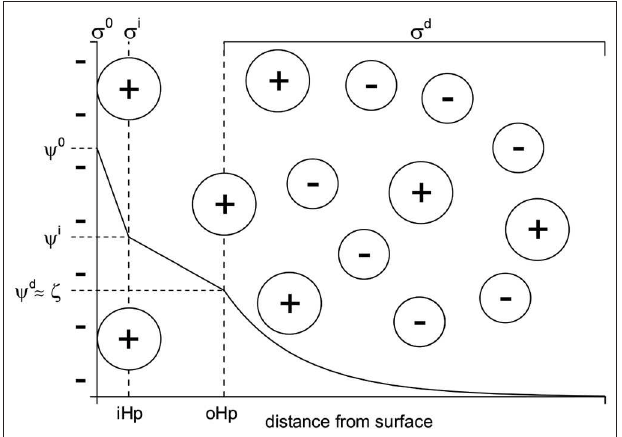
FIGURE 2 | Speciation of Al in 0.5 mM AlCl 3 solution, assuming that all Al available can be precipitated into amorphous Al(OH) 3 . Only dominant species are